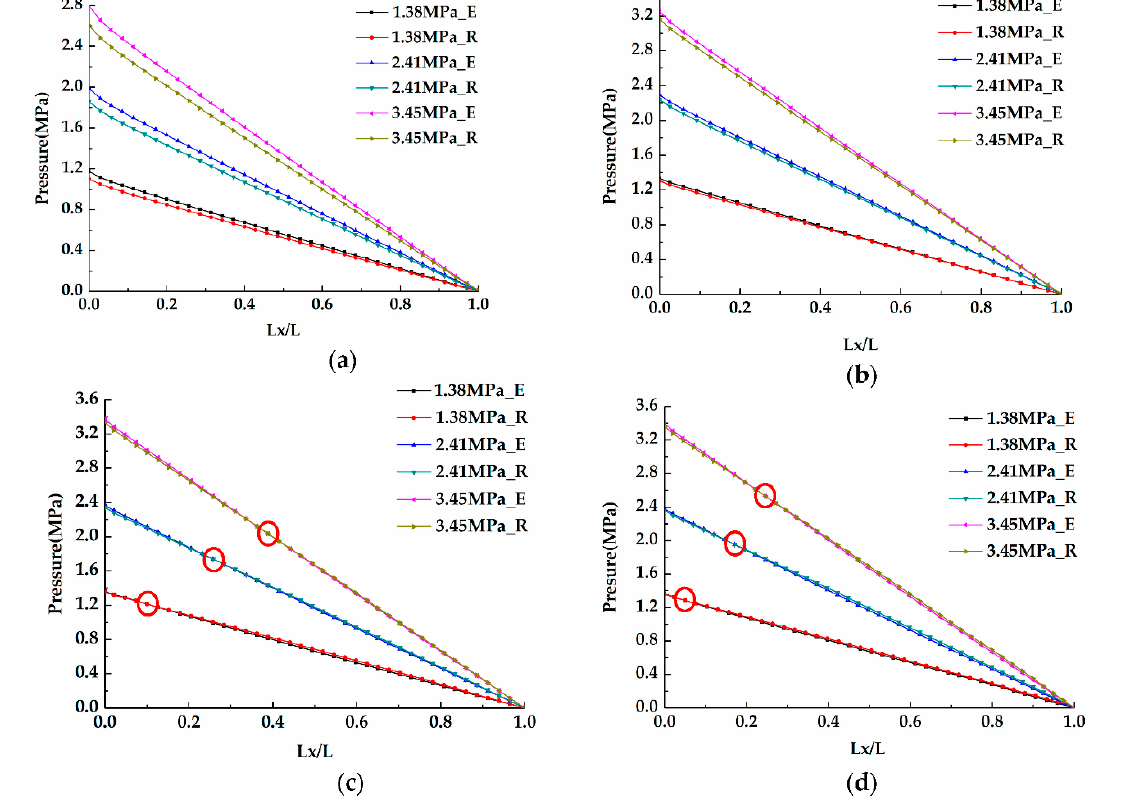
Figure 13. Static pressure distribution on the maximum clearance and minimum clearance: ( a ) 13.13 mm (L / D = 0.17), ( b ) 38.1 mm (L / D = 0.5), ( c ) 76.2 mm (L / D = 1.0), ( d ) 91.44 mm (L / D = 1.2).